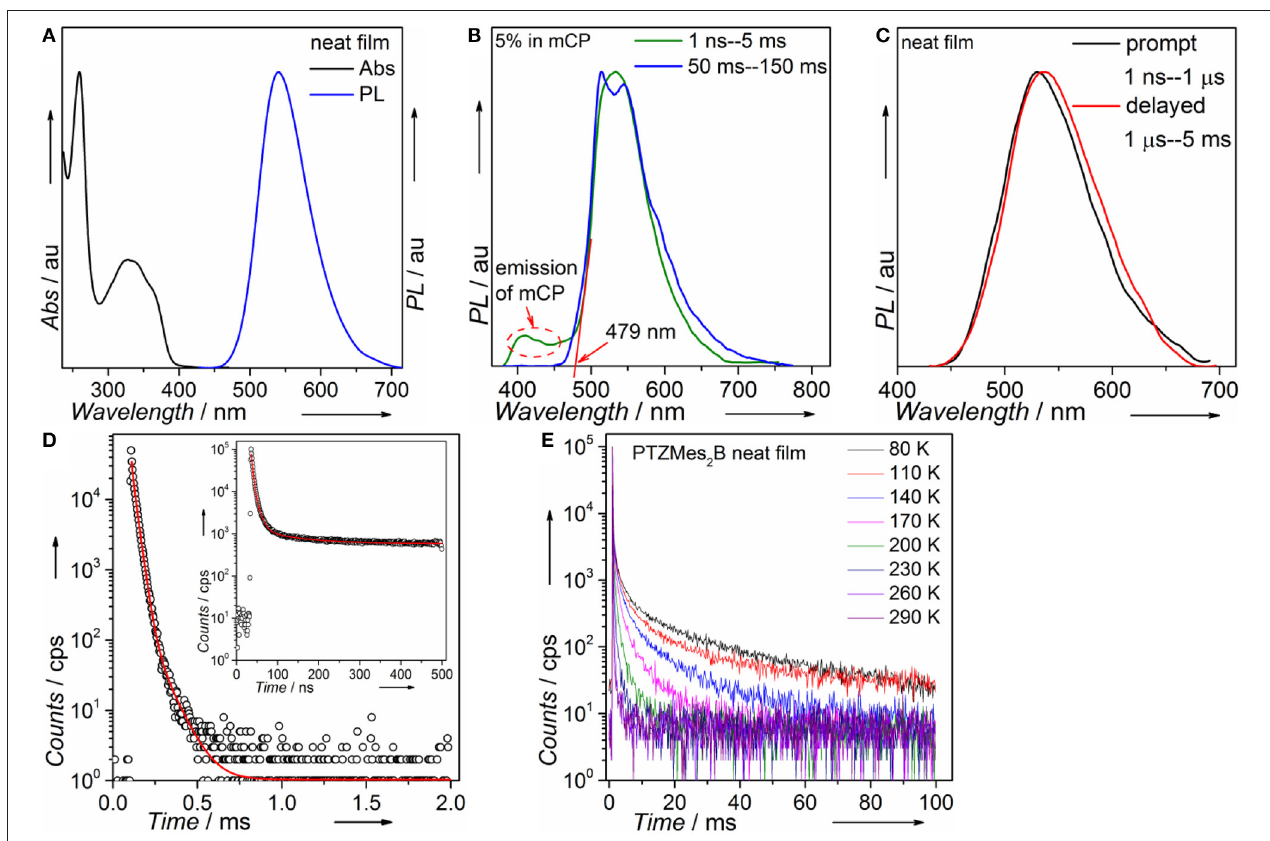
FIGURE 4 | (A) Absorption and PL of PTZMes 2 B in neat film; (B) fluorescence (green line) and phosphorescence (blue line) of PTZMes 2 B doped film (wt. 5% in mCP); (C) prompt (dark line) and delayed (red line) fluorescence of PTZMes 2 B in neat film; (D) PL decay of PTZMes 2 B in neat film (inset: decay in the time range of 500 ns); (E) temperature-dependent transient PL spectra of PTZMes 2 B neat film under vacuum